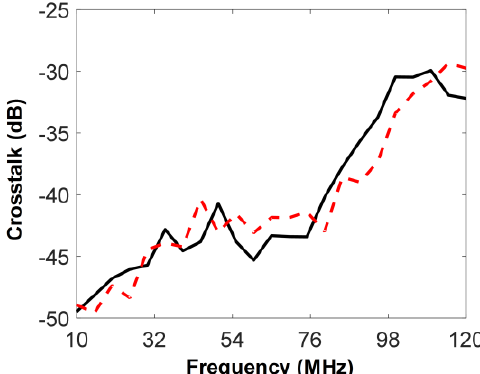
Figure 9. Measured crosstalk of the fabricated dual-element IVUS transducer. The solid line represents the crosstalk measured at the 105-MHz element while exciting the 35-MHz element. The dashed line indicates the crosstalk measured at the 35-MHz element while exciting the 105-MHz element.